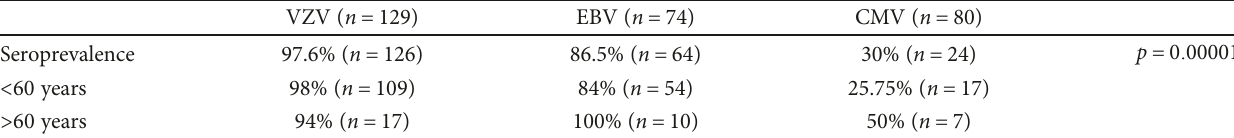
Table 2: VZV, EBV, and CMV